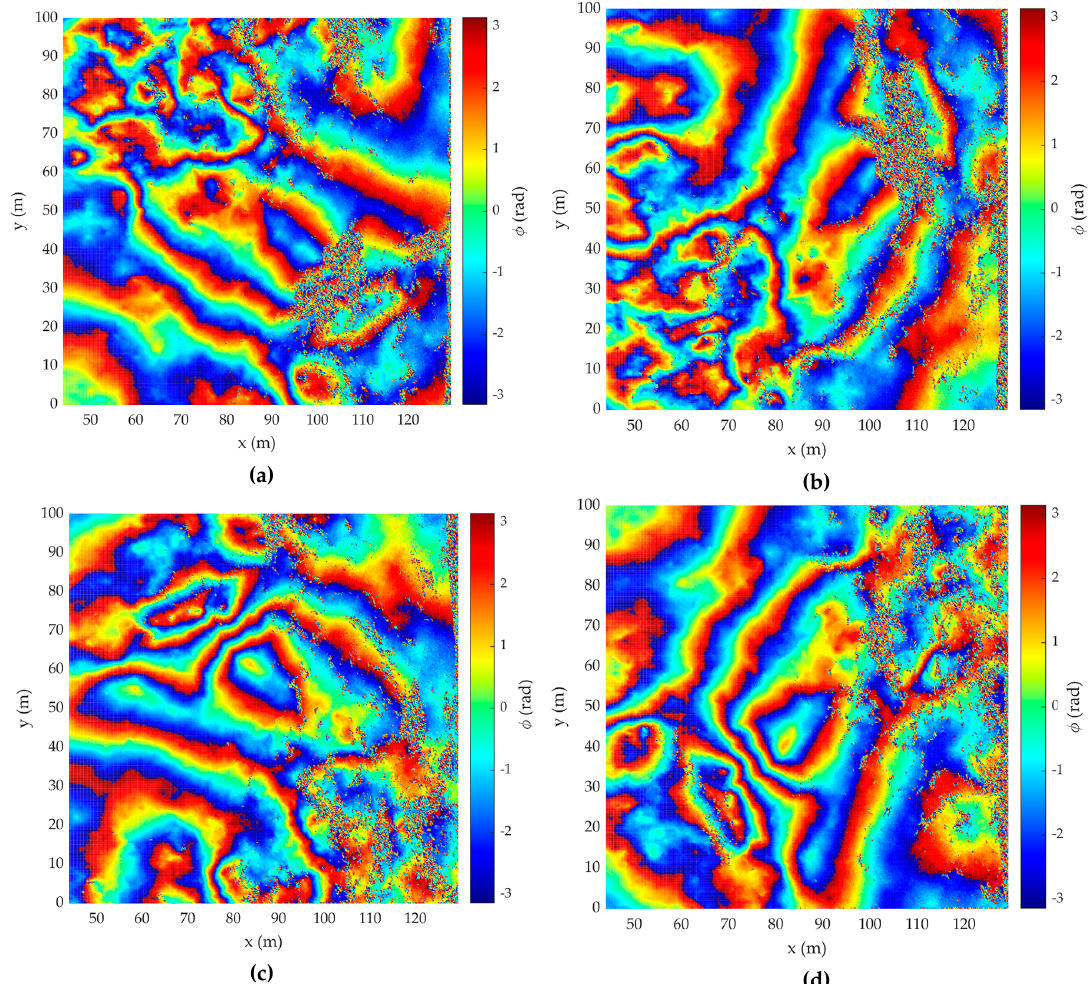
Figure 5. IPD after removing the flat Earth IPD of ( a ) acquisition 1; ( b ) acquisition 2; ( c ) acquisition 3; ( d ) acquisition